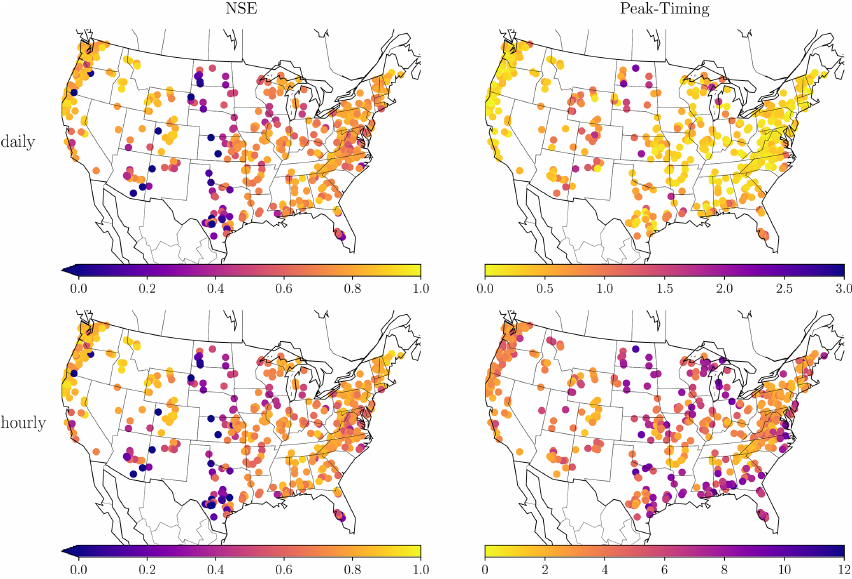
Figure 4. NSE and peak-timing error by basin for daily and hourly sMTS-LSTM predictions. Brighter colors correspond to better values. Note the different color scales for daily and hourly peak-timing